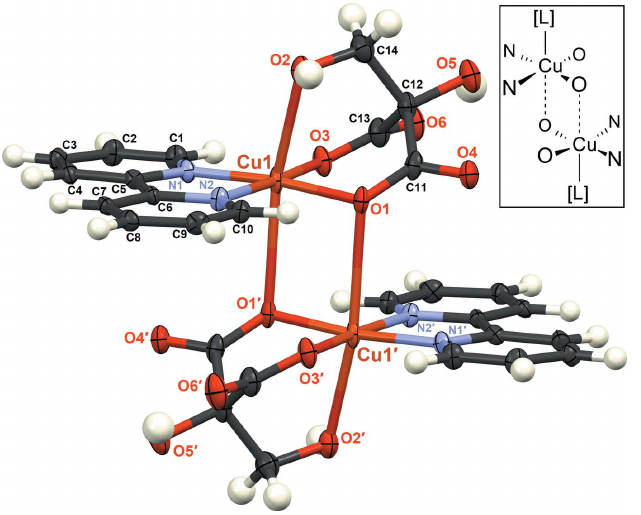
Figure 2 Crystal structure of (I). Ellipsoids are drawn at the 50% probability level; hydrogen atoms are displayed but not labeled. Primed and unprimed atoms are related by an inversion center, which brings the two square- pyramidal Cu(bpy)(C 4 H 4 O 6 ) moieties into contact [Cu (cid:2)(cid:2)(cid:2) O1 0 = 2.703 (2) A˚ ]. The inset is a schematic illustration of the dimerization.